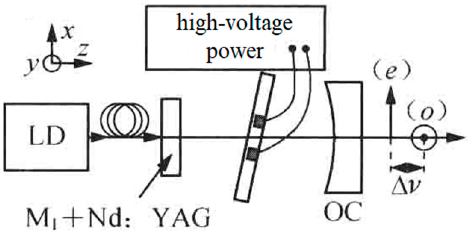
Figure 11. Schematic diagram of electro-optical birefringent dual-frequency Nd:YAG laser [25]. LD: laser diode; M: mirror; OC: output coupler.